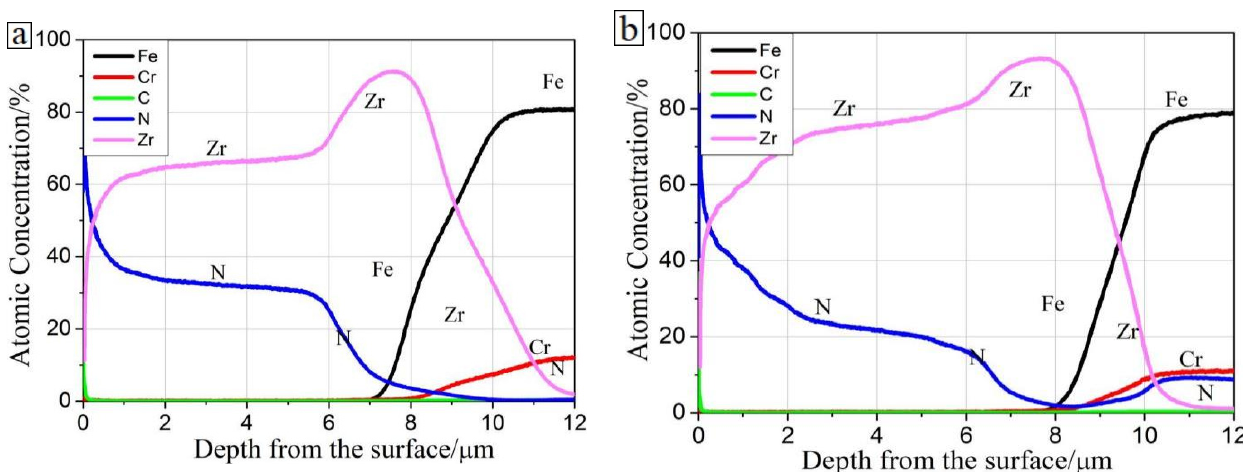
Figure 6. Element distribution curve vs. layer-depth (atom percentage). ( a ) Coating #1 single layer, ( b ) Coating #3 gradient layer.